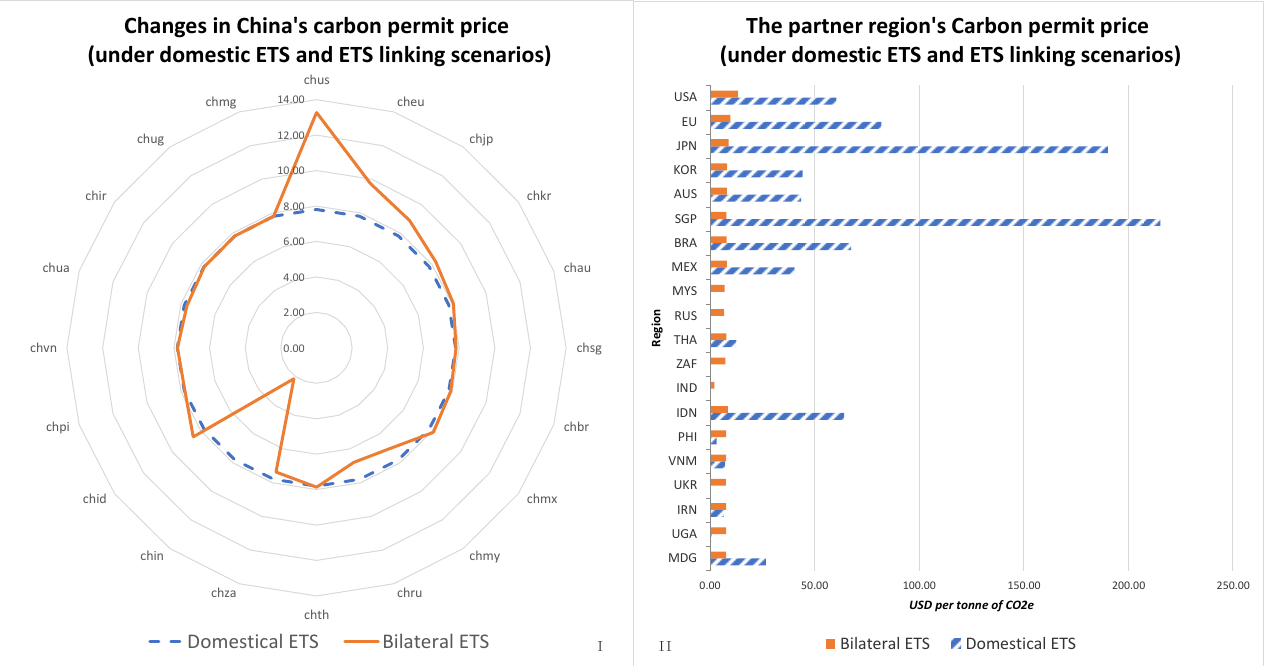
Figure 2. Fluctuating regional prices for carbon permits in various scenarios. ( I , II) , under domestic ETS and ETS linking scenarios, carbon permit prices change in China ( I ) and the partner regions ( II